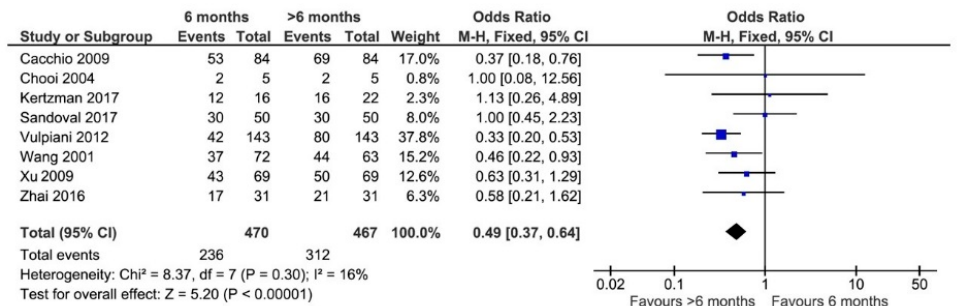
Figure 3. Scatter plots for the number of pulses and healing rates for femurs ( a ) and tibiae ( c ). Scatter plots for the energy flux density and healing rates in femurs ( b ) and tibiae. ( d ) For Figures ( a – d ), the size of each plotted data point represents the number of patients in the study [25,26,29,38,39,43,44,50].